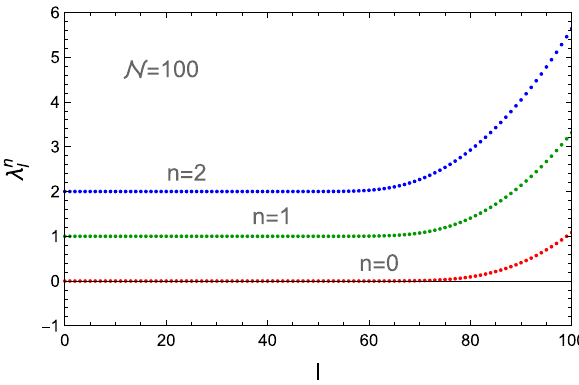
( n = 0 , 1 , 2 ) as func- l